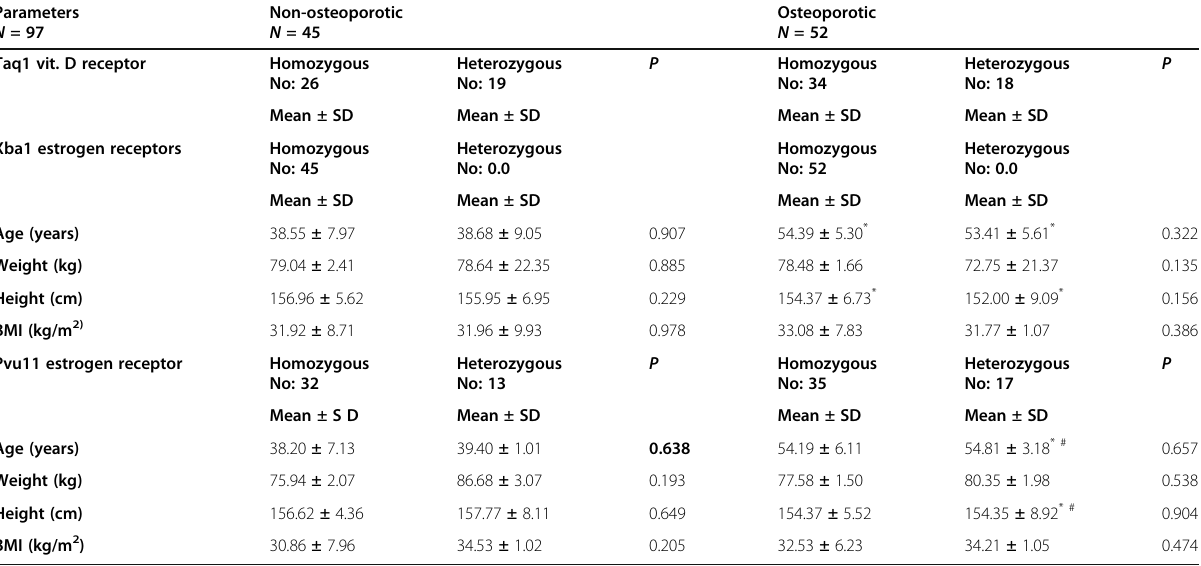
Table 3 Comparison between different studied estrogen receptors genes genotypes regarding the related investigated parameters Parameters N =